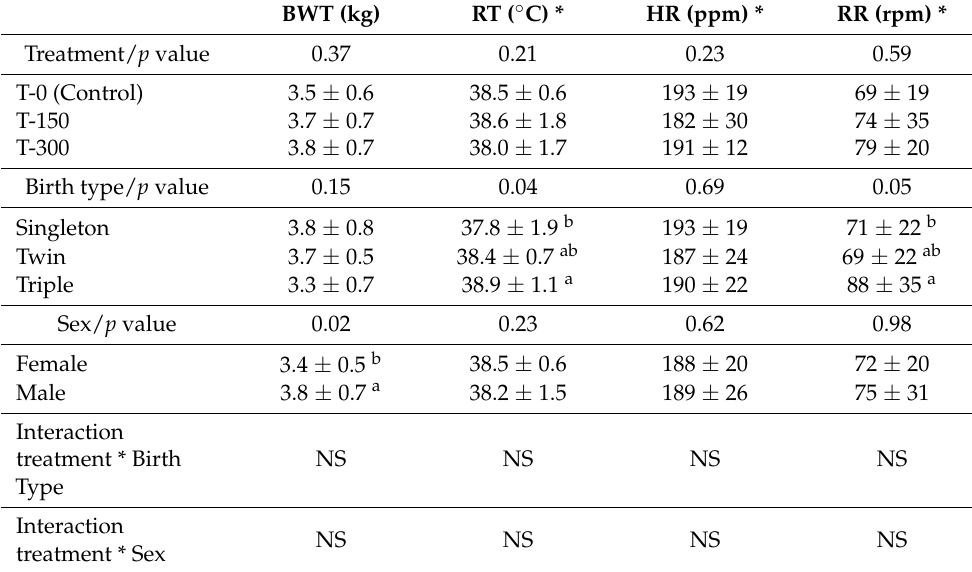
Table 2. Birth weight (BWT), rectal temperature (RT), heart rate (HR), and respiratory rate (RR) in the progeny from French Alpine goats that received 0 (T-0), 150 g/head daily (T-150), or 300 g/head daily (T-300) of energy supplement during the last third of